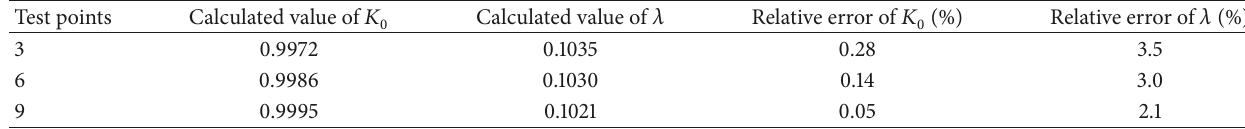
Table 2: The value of 𝐾 0 , 𝜆 and the average relative error.